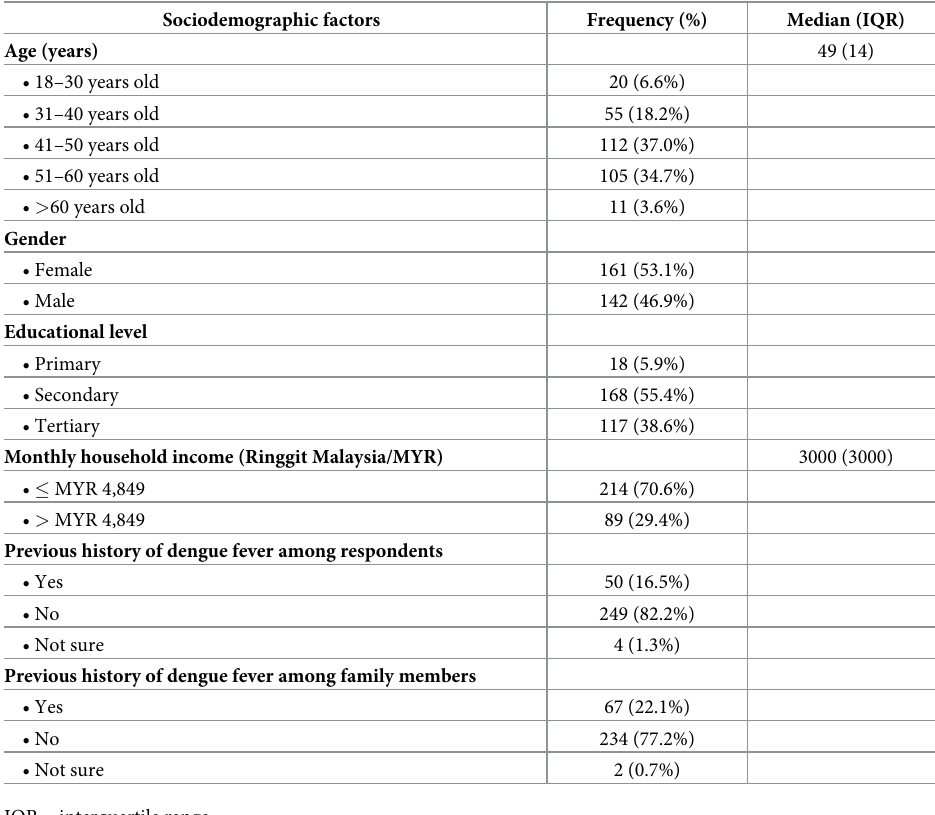
Table 1. Sociodemographic characteristics of the head of household and history of dengue